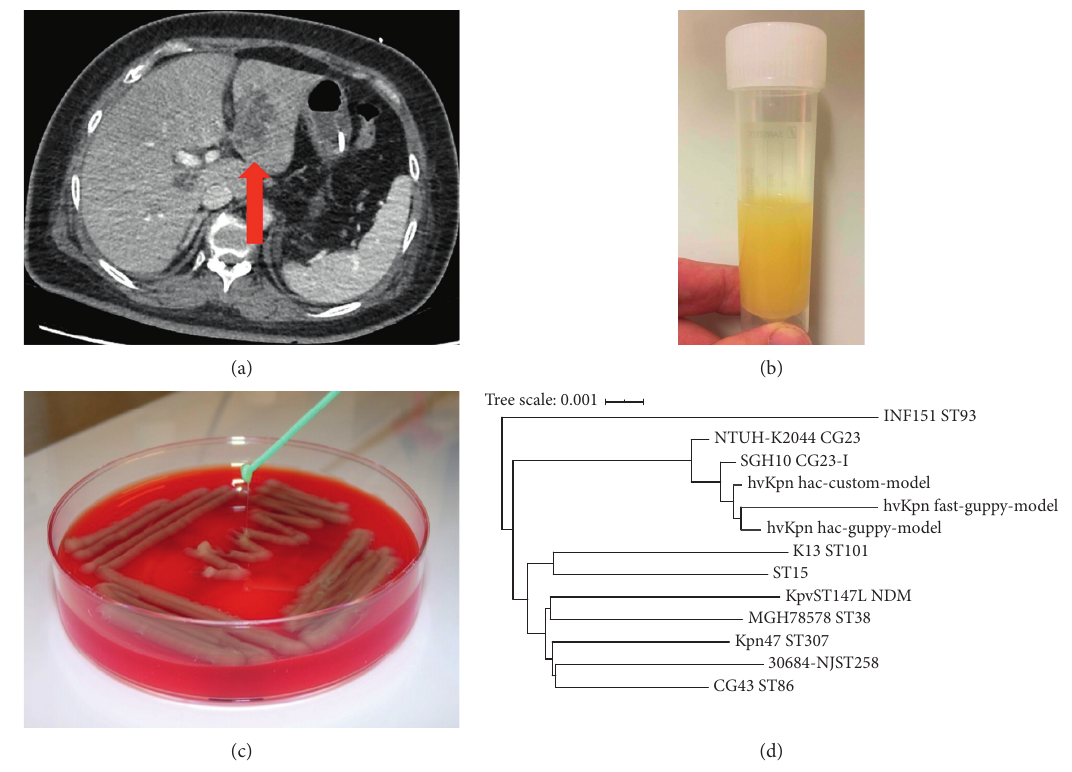
Figure 1: (a) Computed tomography scan of the abdomen showing multiple liver abscesses. (b) Universal container with turbid cere- brospinal fluid. (c) Blood agar plate with Klebsiella pneumoniae culture. (d) Genome distance tree comparing the clinical hypervirulent K. pneumoniae isolate with 10 reference K. pneumoniae isolates produced using